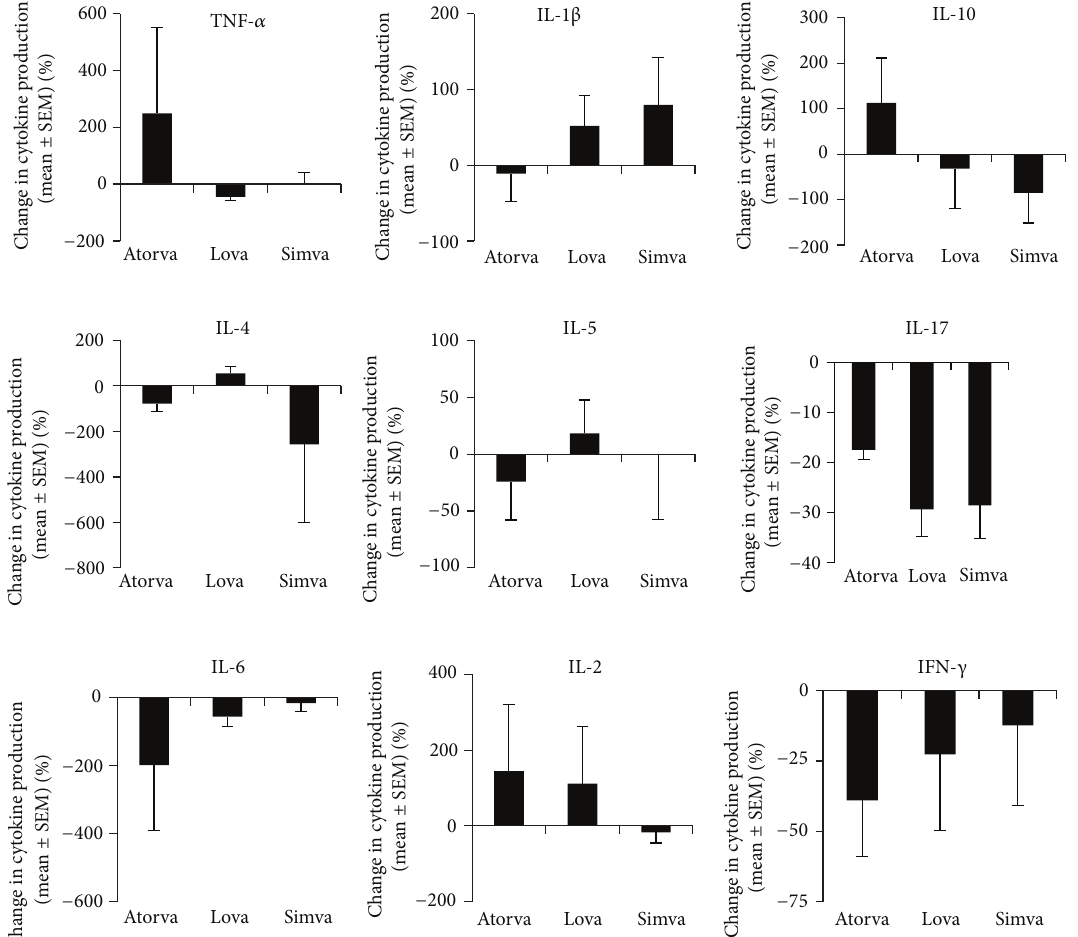
Figure 3: Graphs showing percentage changes in cytokine production by cells cultured with PMA/ionomycin ± statins. These studies show a multitude of varied responses indicating that the different statins have slightly different profiles of